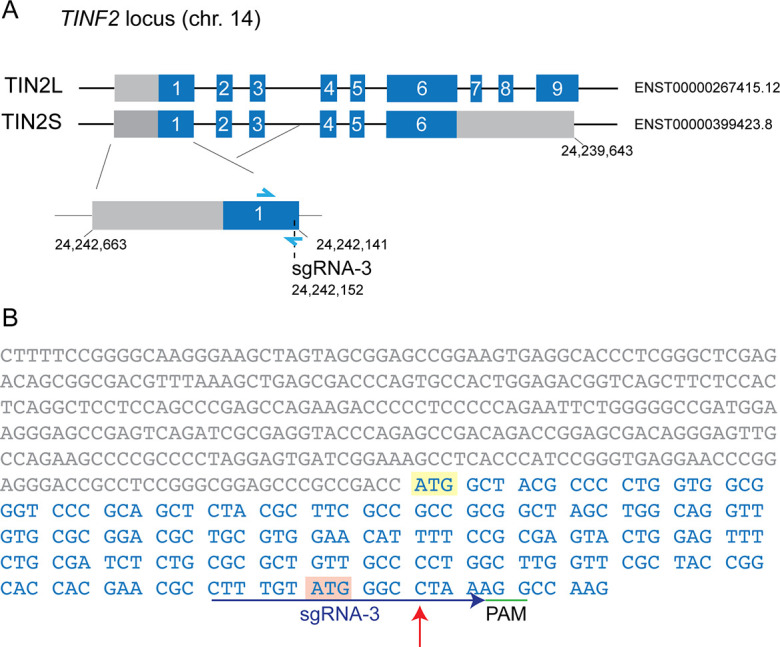
Strategy to generate TIN2+/- RPE1 clones.(A) Schematic of the TINF2 locus showing landmarks relevant to CRISPR/Cas9-mediated targeting of exon1. The single guide RNA (sgRNA) target region and the primers used for genotyping (blue arrows) are indicated. (B) Sequence of TINF2 exon 1 with the 5′ UTR (gray) and coding region (blue). The PAM (green) and sgRNA sequence (blue) is indicated.